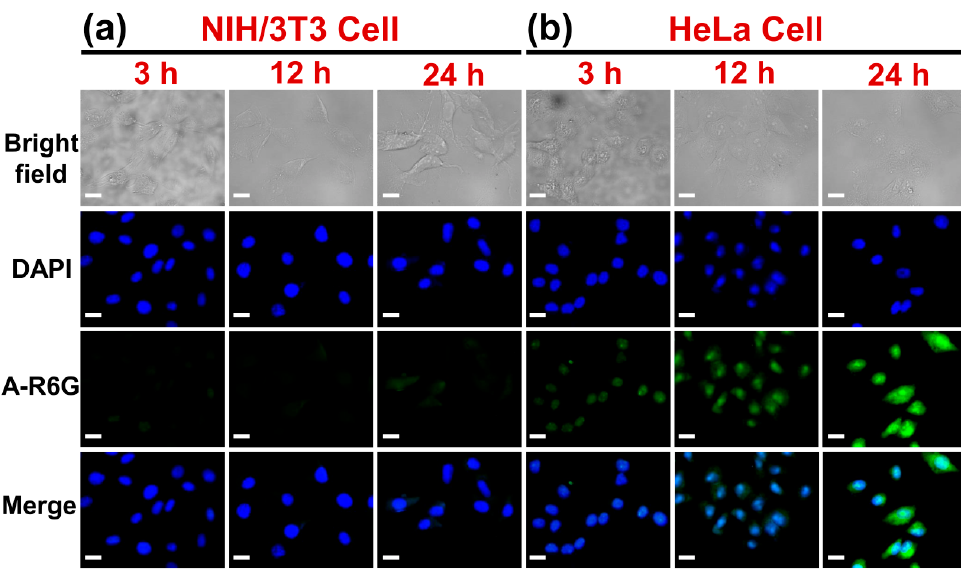
Figure 4. CLSM images of ( a ) NIH/3T3 cells and ( b ) HeLa cells cultured with A-R6G-loaded BU-PEG nanogels at normal physiological conditions (pH 7.4 and 37 °C) for 3, 12, or 24 h. The scale bars in all CLSM images are 20 μ m.